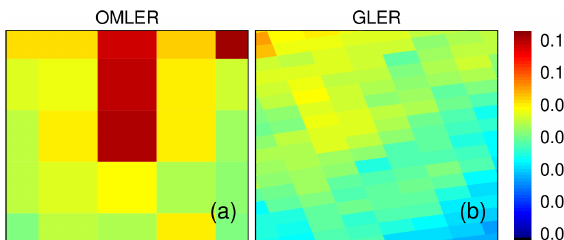
Figure 6. Surface LER at 440nm over the selected area in the Shenyang region of northeastern China for OMI orbit 3843 on 5 April 2005; (a) monthly climatology at the original spatial resolu- tion; (b) GLER computed for individual OMI